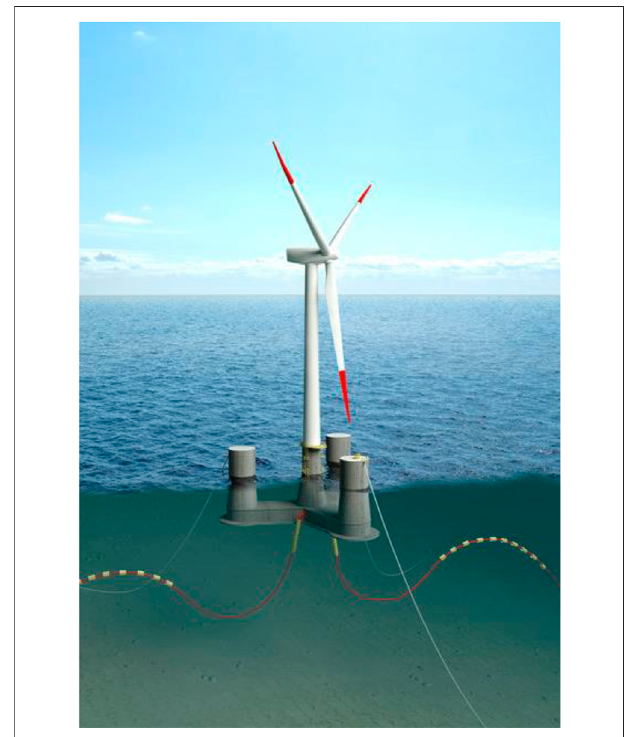
FIGURE 1 | The 10-MW OO-Star fl oating wind turbine (Yu et al.,